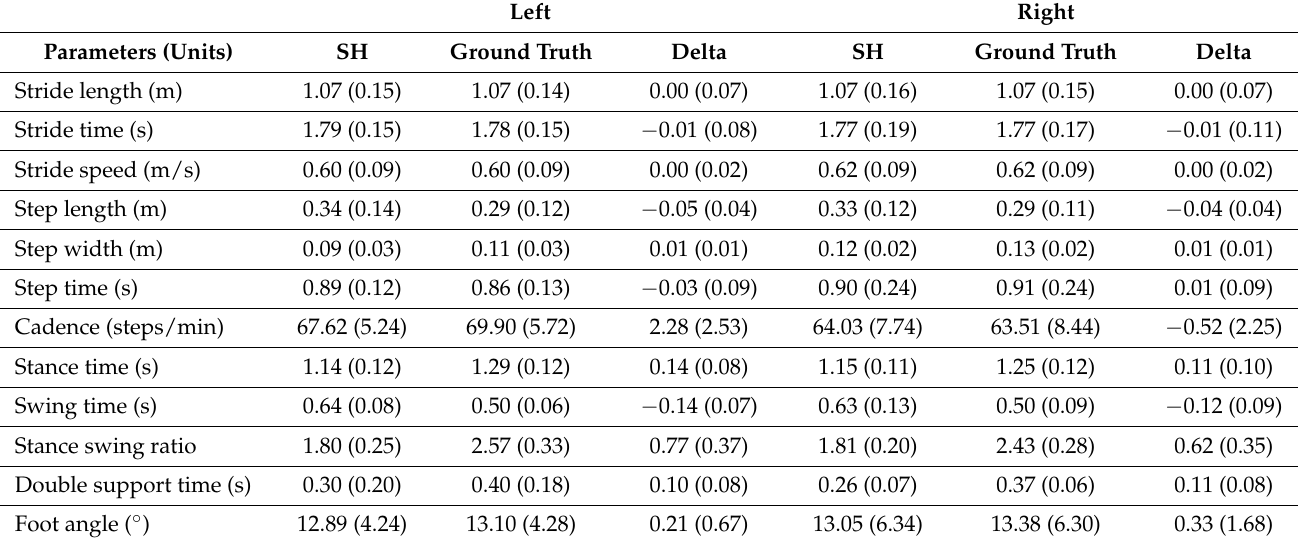
Table 11. Stride parameters for participant one from the Smart Hallway (SH) compared to ground-truth foot-event stride parameters for the walker test (mean and standard deviation in